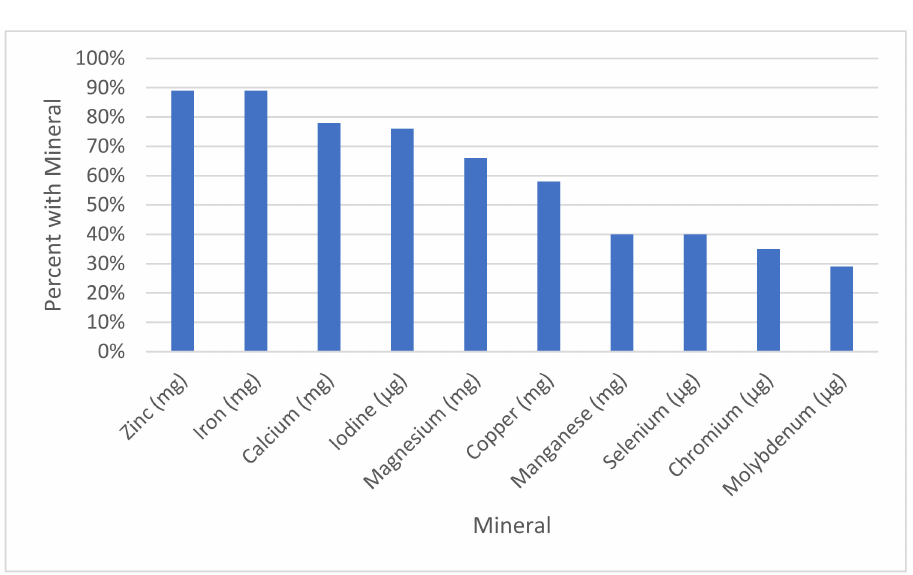
Figure 1. Percent of Supplements with this